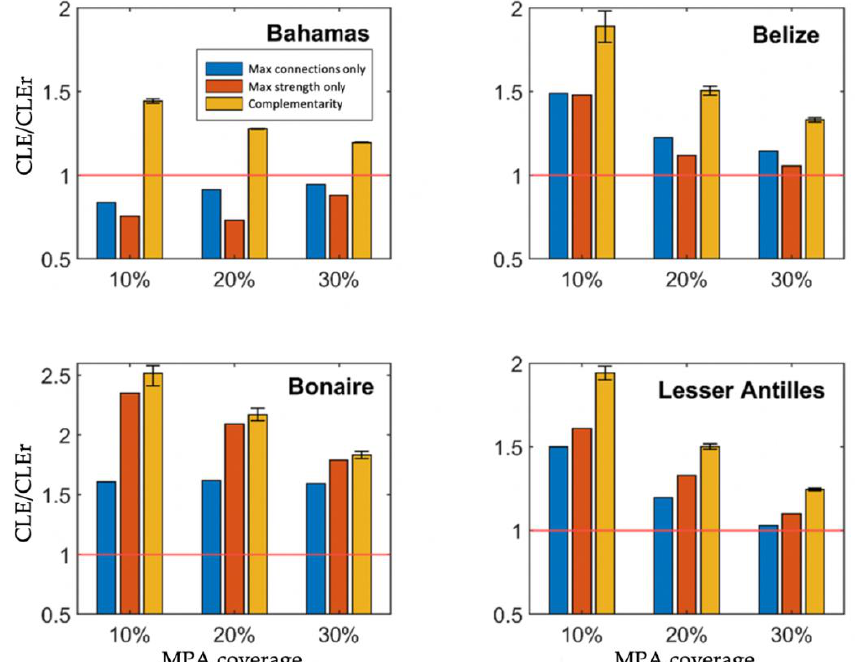
Figure 3. Connectivity reserve selection methods compared relative to random reserve selection, across three MPA coverage scenarios, at a 10% larval threshold. Constrained larval export (CLE) of connectivity methods (complementarity algorithm, strength, and connections) were standardised against average CLE of random MPA network design (CLEr). CLE values above 1, highlighted by red horizontal lines, represent better results than CLEr. One thousand simulations were run for algorithm reserves and random selection. Average algorithm performance is represented by the bar value labelled “ Complementarity ” , accompanied by a min and max interval range for all simulations. “Max connections only” and “Max strength only” represent MPA systems that optimise fixed metrics — export connections and export strength, respectively.